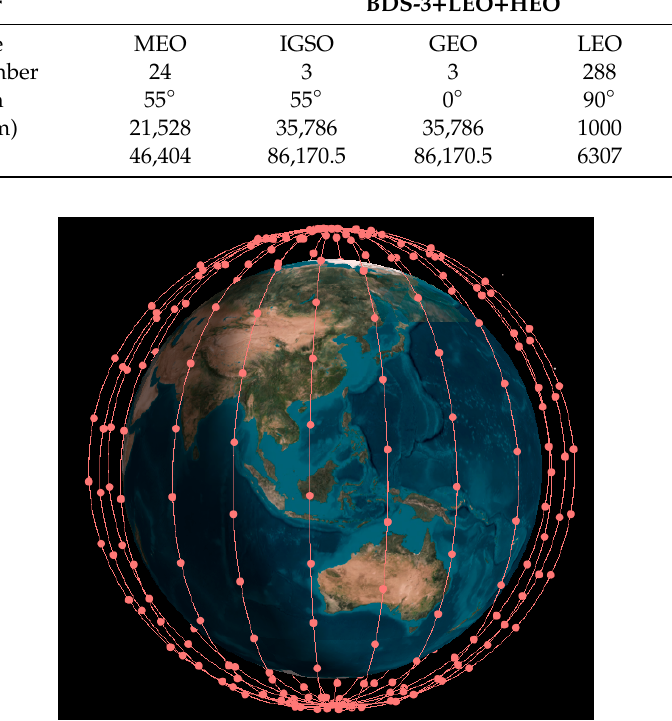
Figure 10. Low earth orbit ( LEO) satellites in the 3D graphic view. Table 8. Parameters of the BDS-3+ low earth orbit (LEO)+HEO constellation.